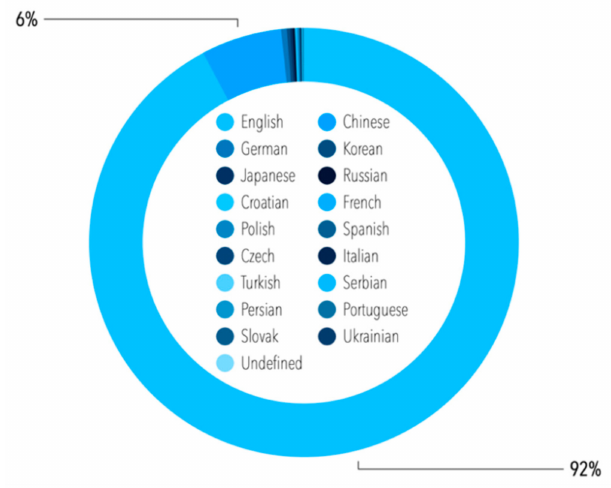
Figure 2. Percentage of publications per